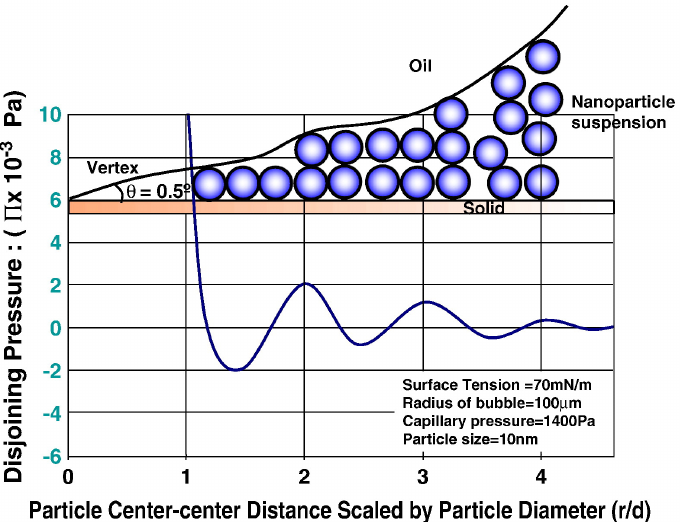
Figure 12. Pressure on the walls of a 0.5° contact angle wedge at the vertex as a function of the dimensionless radial distance. Particle volume fraction V m = 0.36 and particle diameter d = 10 nm. Figure reproduced from Ref. [84].